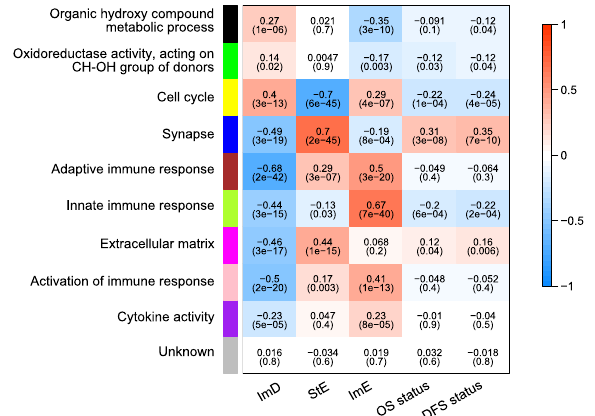
Fig. 8 Nine gene modules signi fi cantly differentiating gastric cancers by the subtypes in ACRG-STAD. WGCNA 69 showing that the immune responses are highly enriched in ImE and are deprived in ImD; the extracellular matrix is highly enriched in StE, and the cell cycle is downregulated in this subtype. Survival prognosis has positive correlations with the cell cycle and innate immune response and negative correlations with the synapse and extracellular matrix. The P values are shown in